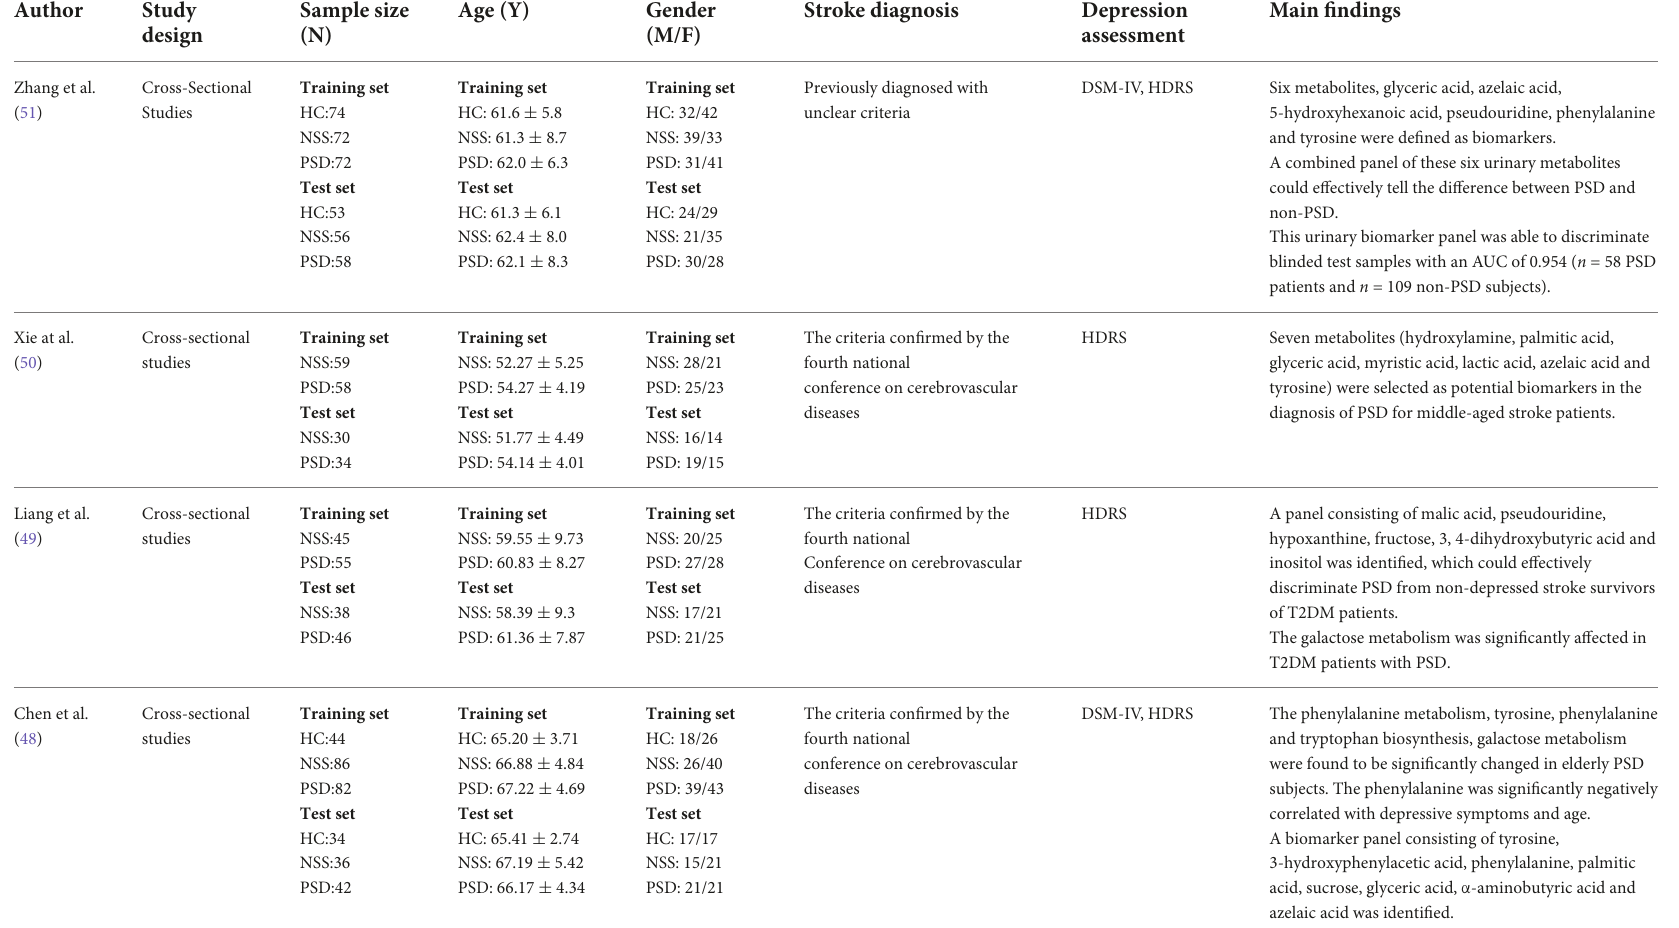
TABLE 1 Characteristics of included